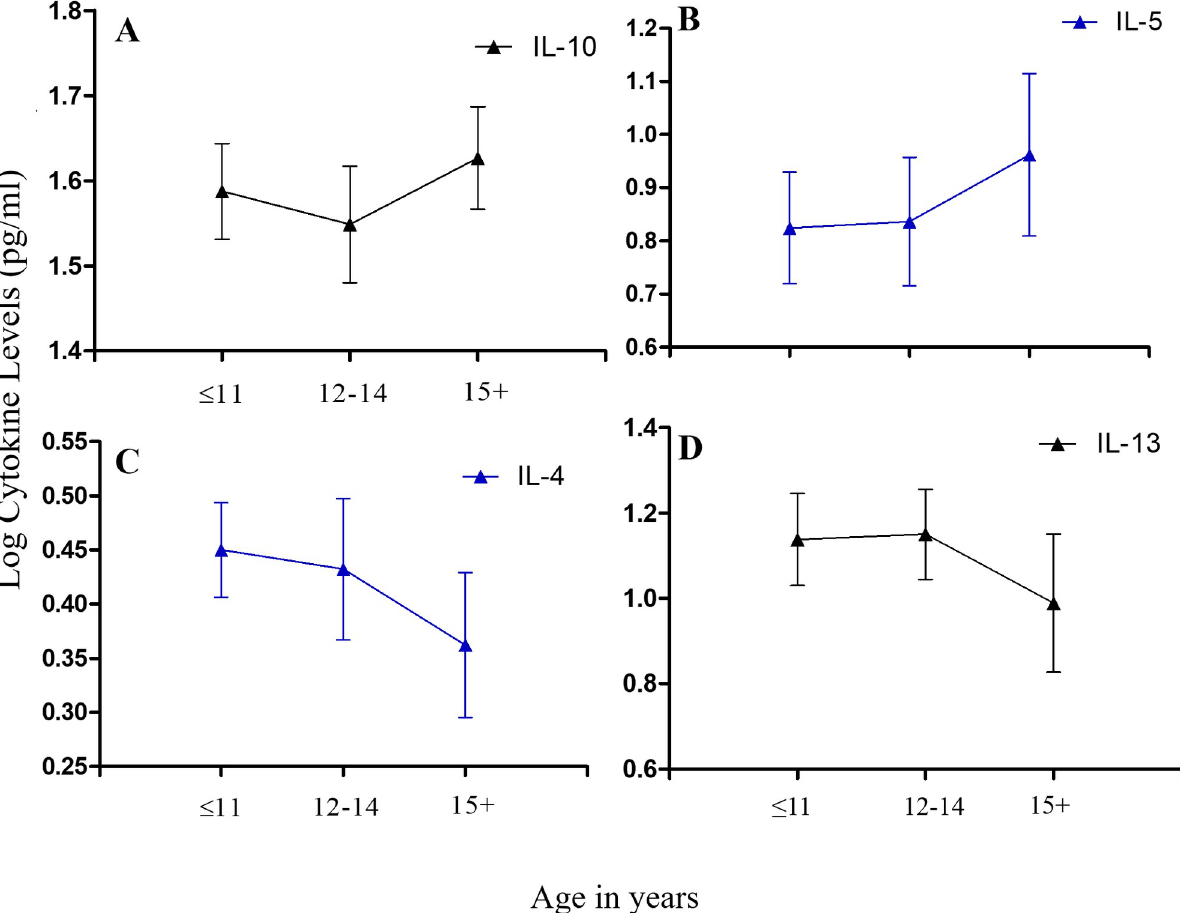
Fig 6. Stratification of measured plasma cytokine levels by age among S . haematobium -infected participants (N = 99): (A) Mean interleukin-10 (IL- 10) titres by age groups; (B) Mean IL-5 titres by age groups; (C) Mean IL-4 titres by age groups and (D) Mean IL13 titres by age groups. Error bars represent the standard error of mean